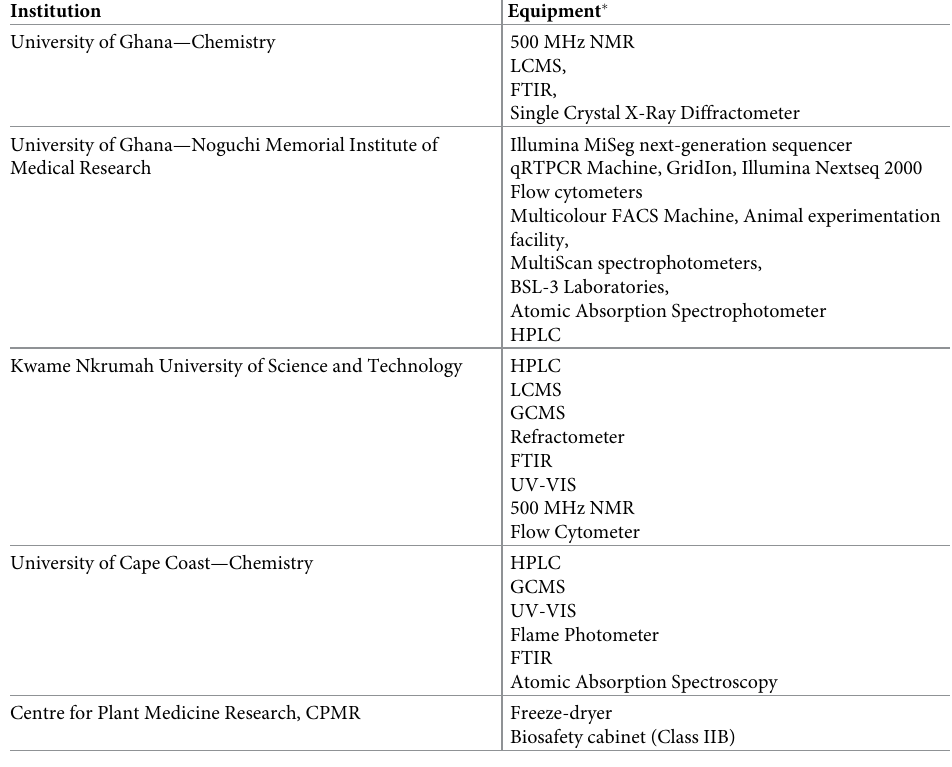
Table 1. Key equipment in